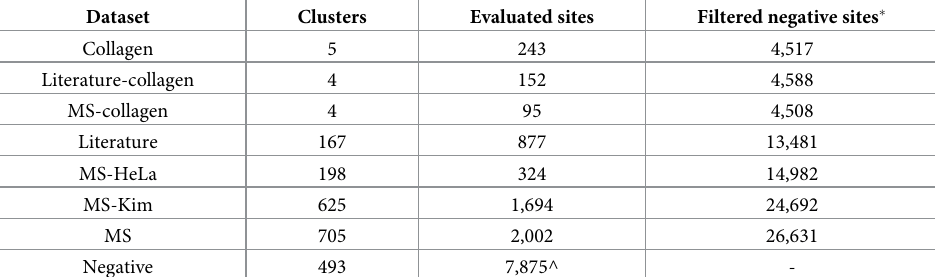
Table 1. Datasets. Negative clusters (“Negative”) contain only clusters with non-hydroxylated sites. Other datasets have clusters with both positive and negative examples, but negatives are completely removed during evaluation ( � ). Negative sites (^) considered during evaluation are always resampled for each replica, based on the size of the positive dataset.